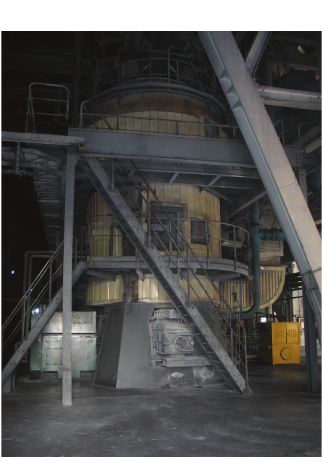
Figure 8: The elevation view of the tested medium-speed mill.